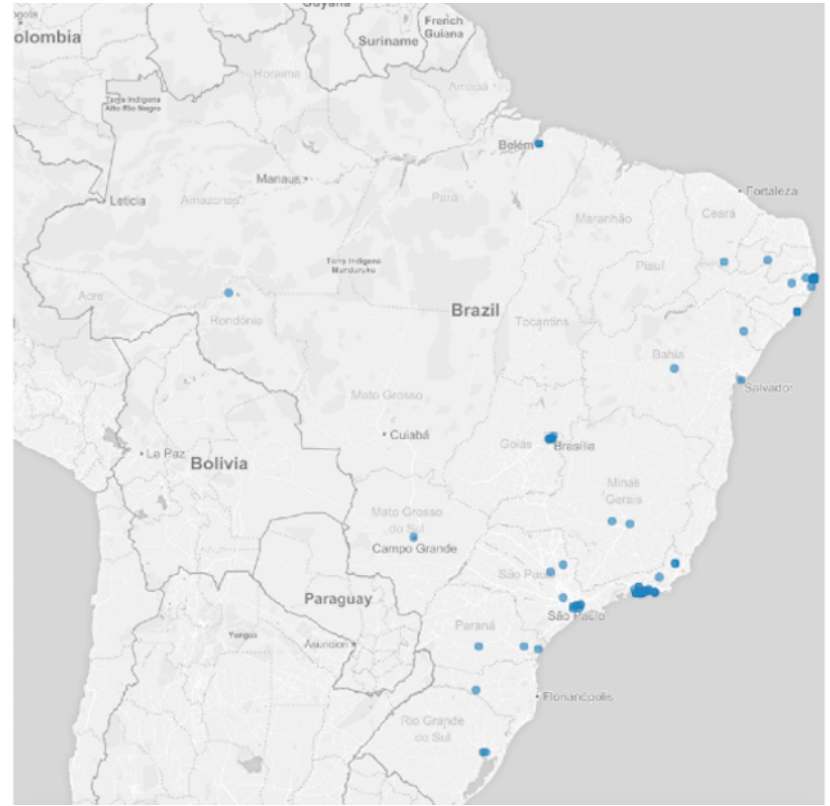
Figure 6. Spatial distribution of reports from users with respiratory syndrome during the 2016 Olympic Games.